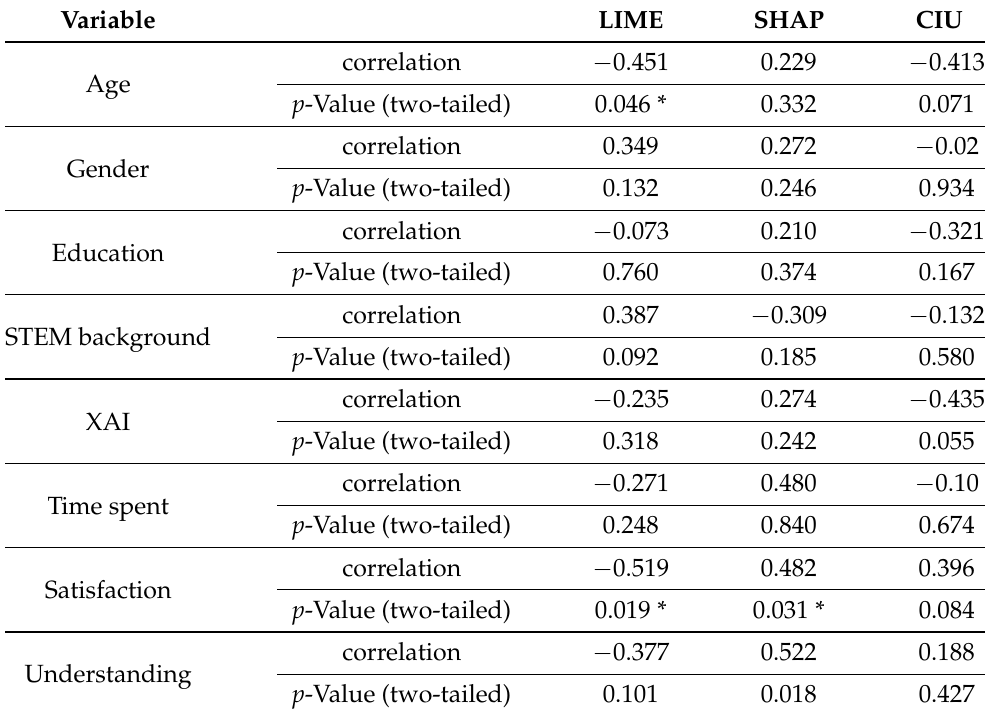
Table 14. Correlation between demographic variables and decision-making in XAI settings (note: * p <